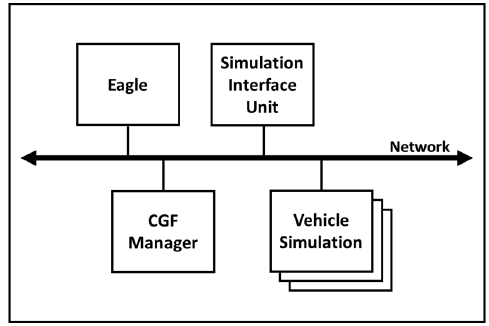
Figure 6. Eagle II architecture block diagram (adapted from [35]).